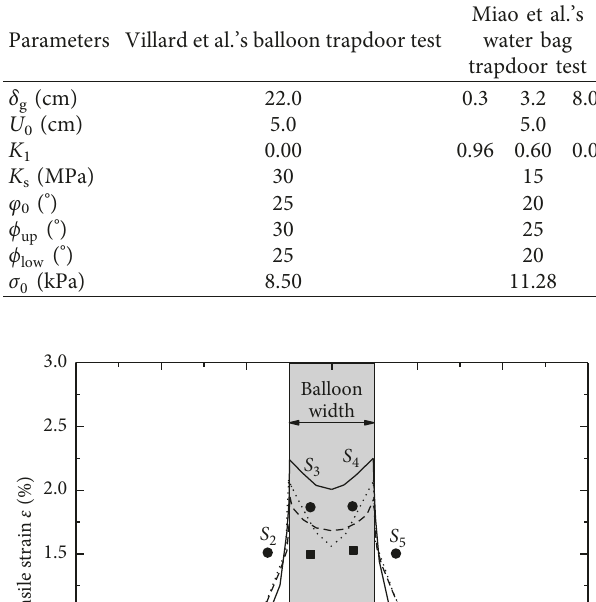
Table 1: Parameters in the calculation process.